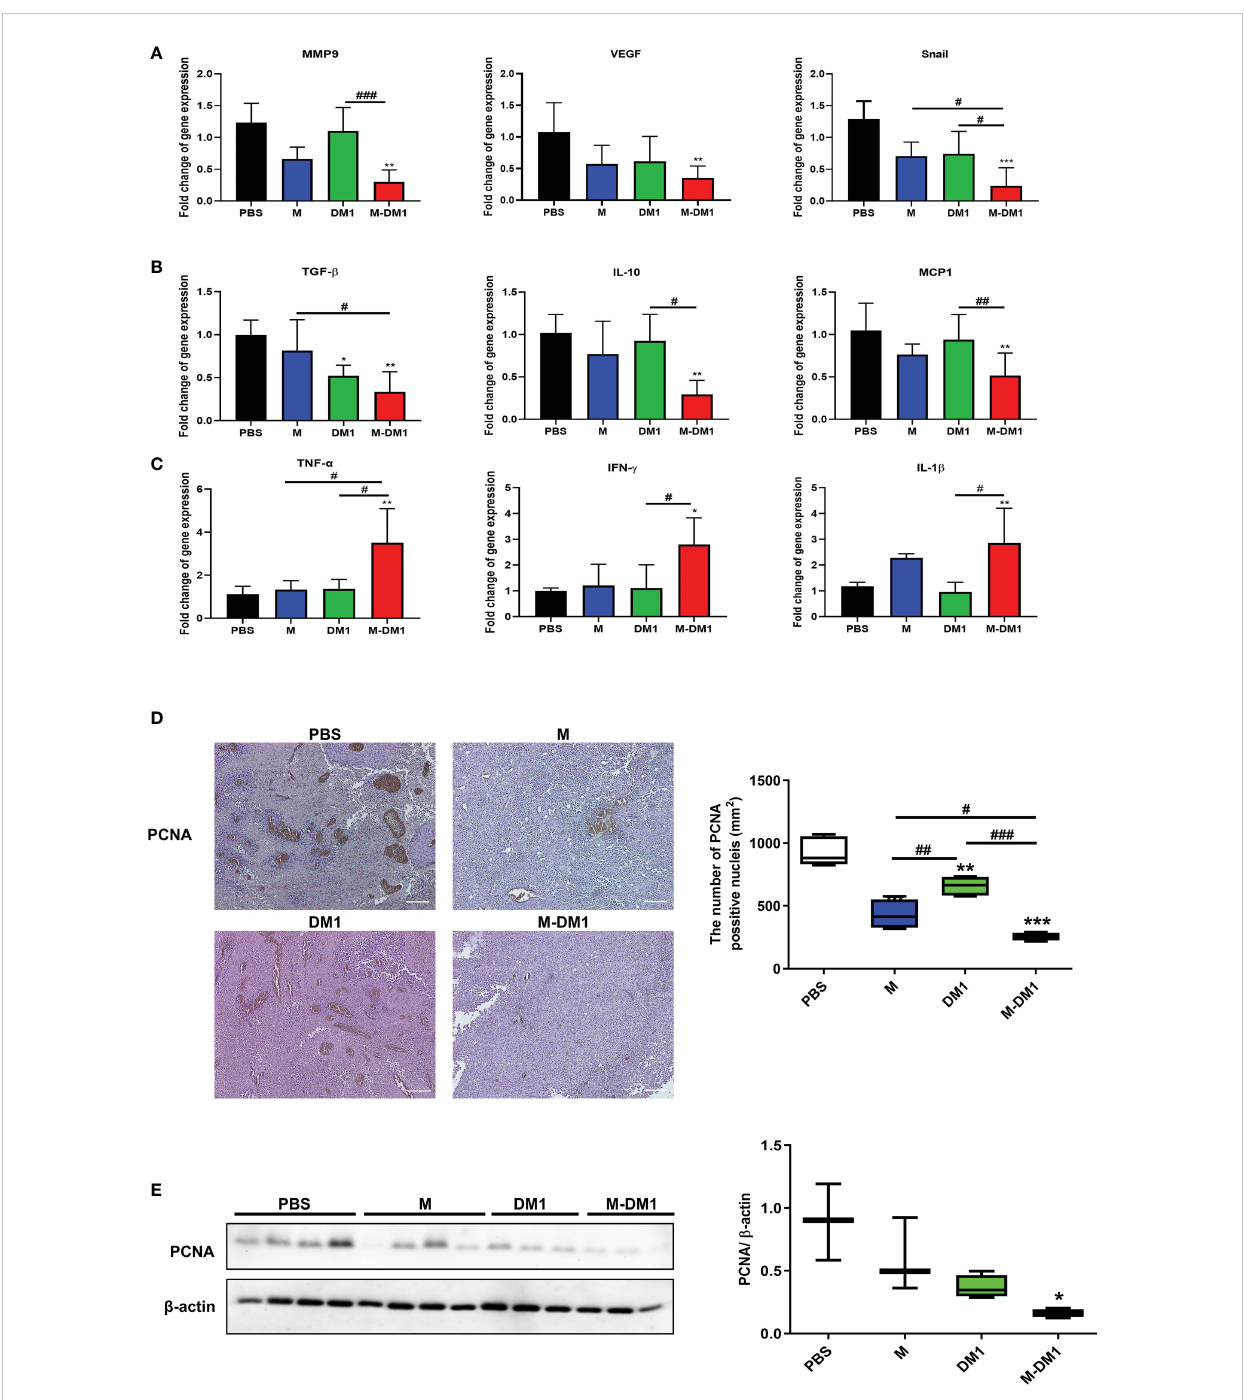
FIGURE 5 M-DM1 treatment suppresses proliferation of melanoma. (A) The expression of epithelial – mesenchymal transition-related markers were analyzed by using qRT-PCR in melanoma tissue (n = 4 ‒ 5). (B) The expression of anti-in fl ammatory cytokines markers were analyzed by using qRT-PCR in melanoma tissue (n = 4 − 5). (C) The expression of pro-in fl ammatory cytokines were analyzed by using qRT-PCR in melanoma tissue (n = 4 − 5). All data are presented the mean ± SD. One-way ANOVA followed by Tukey ’ s post-hoc test was performed for group comparisons; *p < 0.05, **p < 0.01, ***p < 0.001 vs PBS group; #p < 0.05, ##p < 0.01, ###p < 0.001 vs M or DM1 group. (D) Immunohistochemistry staining was used to analyze the expression of PCNA, a proliferation marker, in tumor tissues (magni fi cation ×10) (n = 4 ‒ 5). (E) The expression of PCNA in tumor tissues were measured by western blotting (n = 4 ‒ 5). All data are presented the mean ± SD. Unpaired Student ’ s t-test was performed; *p < 0.05, **p < 0.01, ***p < 0.001 vs PBS group; #p < 0.05, ##p < 0.01, ###p < 0.001 vs M or DM1